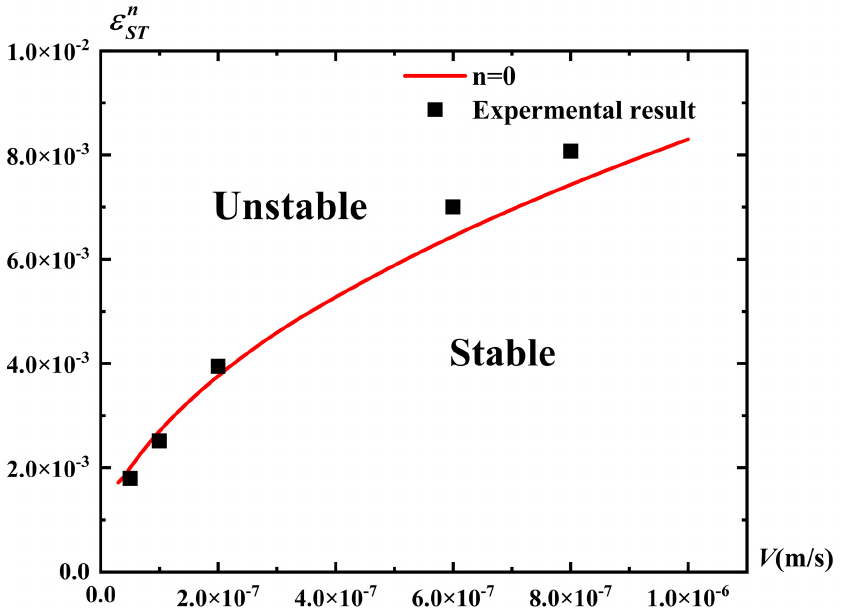
( n = 0 ) versus V for the typical case ( ∆ s > 0), where ST